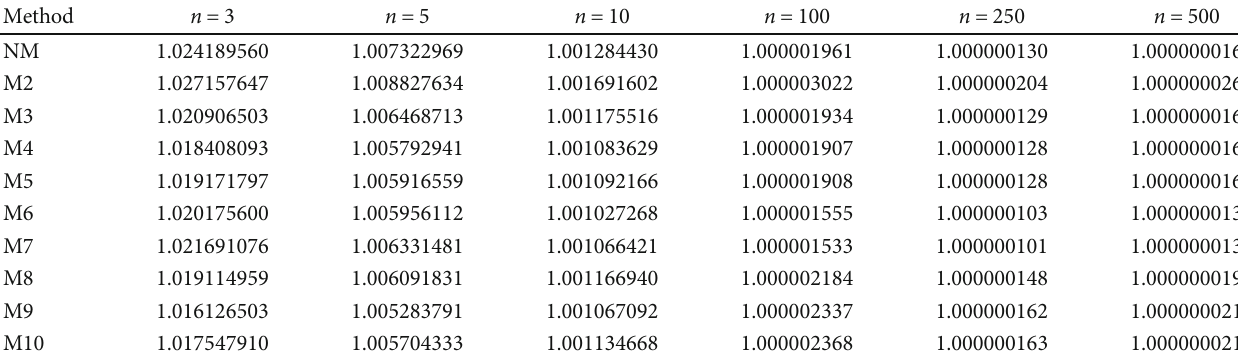
Table 25: The values of CI for the methods in the fi rst category to solve Test Problem 1, and n = 3, 5, 10,100,250,500 . Method